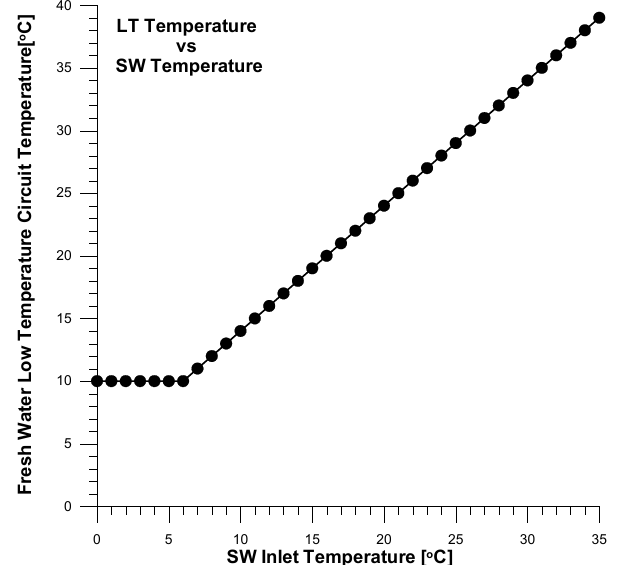
Figure 2. Variation of fresh water LT system temperature with SW inlet temperature [9]. Explanation of abbreviations: LT = Low Temperature, SW = Sea